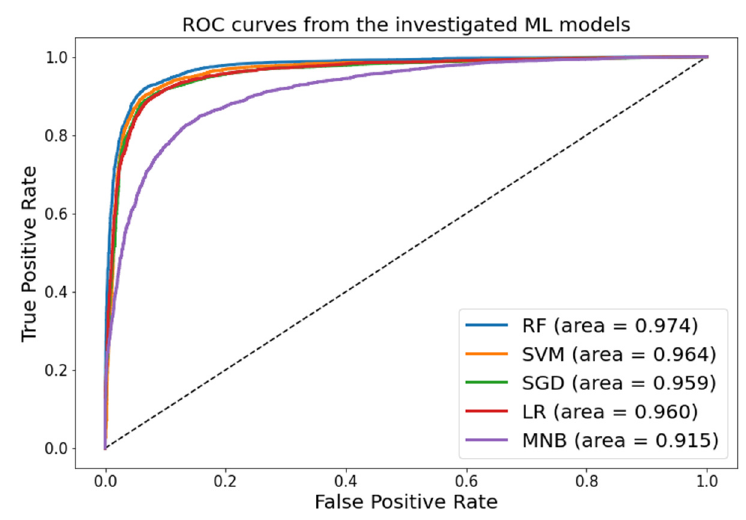
Figure 6. AUC ROC curve for each ML model.